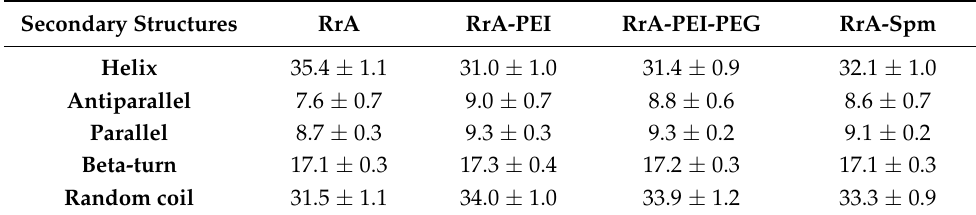
Figure 4. CD spectra of the native enzyme and RrA-PEI-PEG, RrA-PEI, and RrA-Spm conjugates. C(RrA) = 1 mg/mL, 0,01 M PBS, 37 °C, pH 7.5.